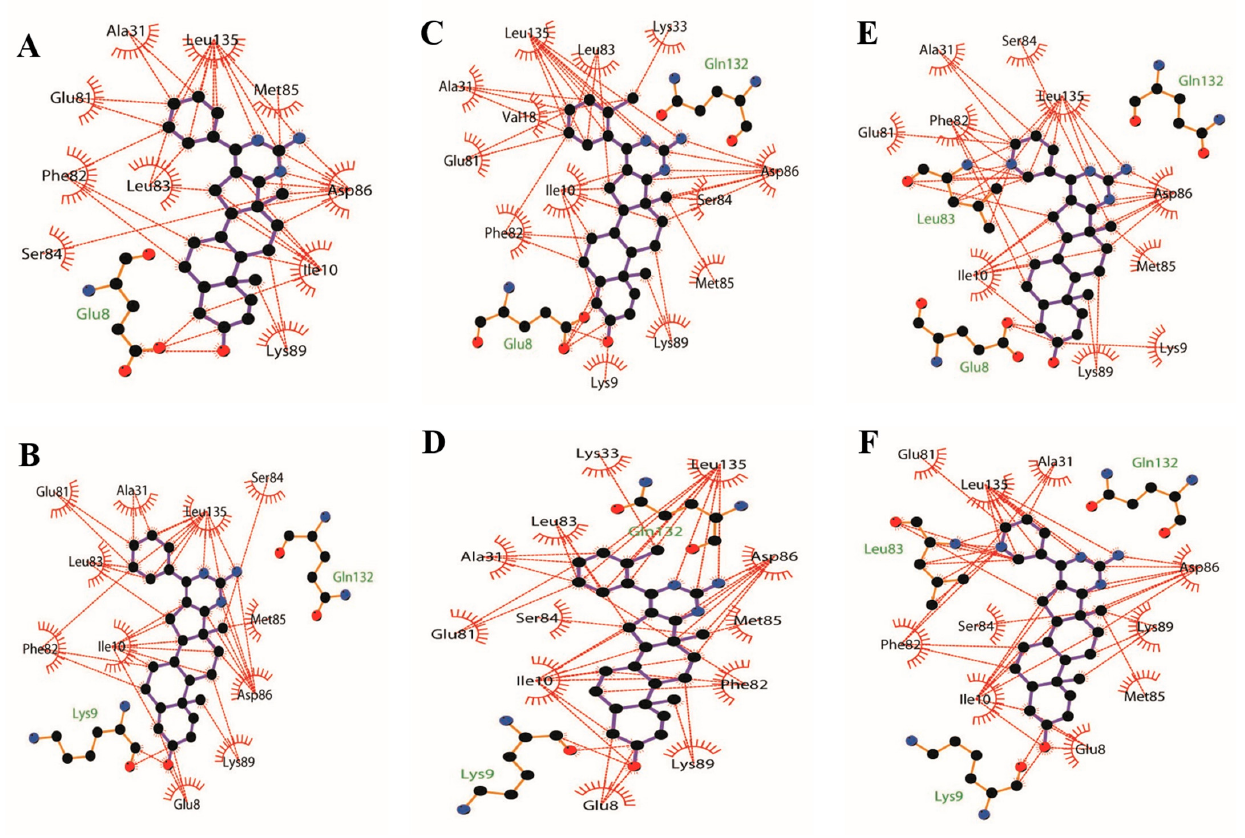
Figure 9. The 2D docked model of compounds 3a , 3b , 3l , 6a , 6b, and 6l into the binding pocket of CDK1 kinase (PDB code: 6GU6, black carbon atoms, red oxygen atoms, yellow sulphur atoms, and blue nitrogen atoms. Brick red dashed lines just display the hydrophobic interaction between the atoms and the amino acids of CDK1). ( A ) Hydrophobic interaction between the atoms of 3a and the amino acids of CDK1; ( B ) Hydrophobic interaction between the atoms of 6a and the amino acids of CDK1; ( C ) Hydrophobic interaction between the atoms of 3b and the amino acids of CDK1; ( D ) Hydrophobic interaction between the atoms of 6b and the amino acids of CDK1; ( E ) Hydrophobic interaction between the atoms of 3l and the amino acids of CDK1; ( F ) Hydrophobic interaction between the atoms of 6l and the amino acids of CDK1. Figures were drawn with LigPlot + .